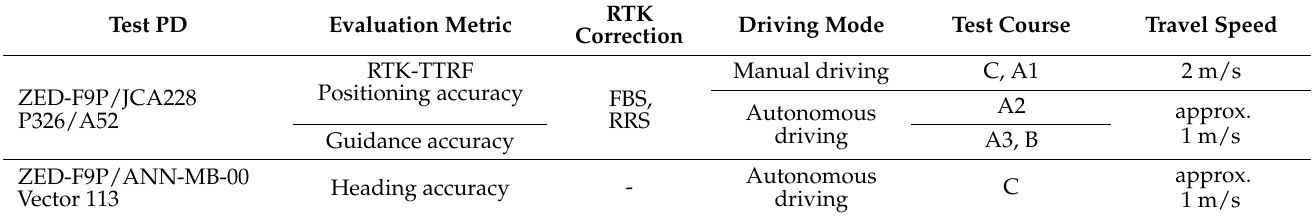
Table 2. Experimental settings for evaluating dynamic performance of the test